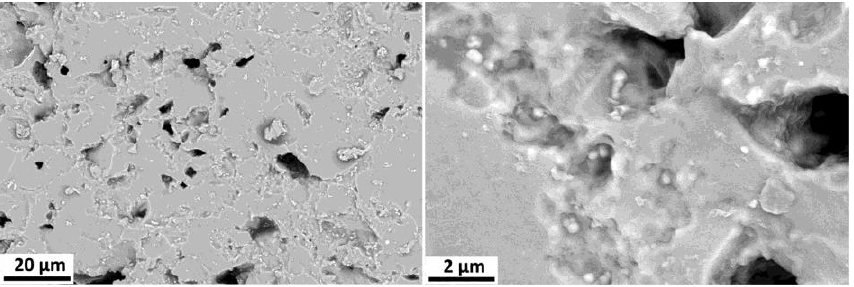
Figure 8. Polysiloxane – polyethyleneglycol porous composite obtained from an emulsion gel (sample EG4).